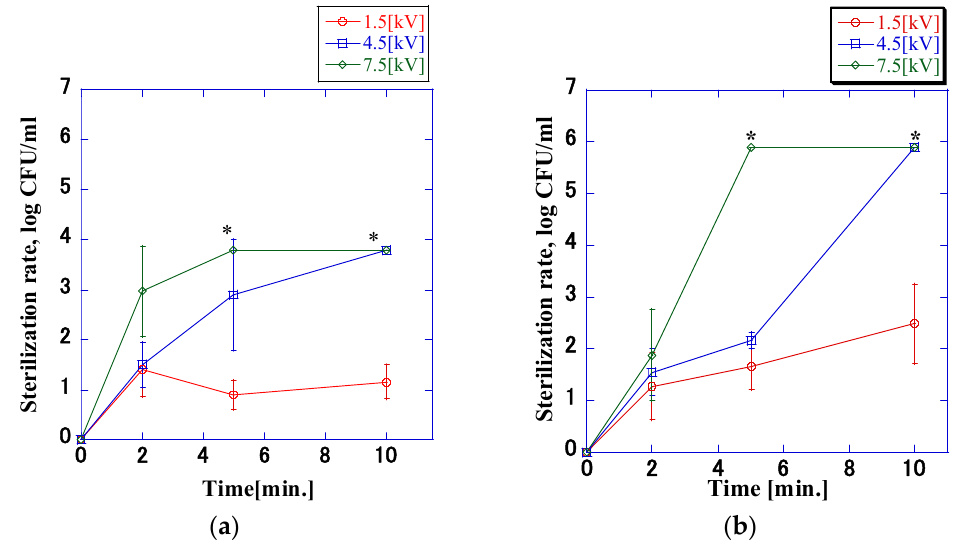
Figure 8. VRE sterilization rate at impulse voltage application times of up to 10 min (pulse width: 1.7 μ s). There was a large difference between the sterilization rates at applied voltages of 4.5 kV and 1.5 kV. In particular, it could not be completely inactivated when the applied voltage was 1.5 kV. This was similar to the result when the impulse voltage with a pulse width of 6.9 μ s was applied. Values calculated with the counts below the detection limit of quantification are marked with an asterisk; ( a ) 8.0 × 10 3 CFU/mL; ( b ) 8.0 × 10 5 CFU/mL.